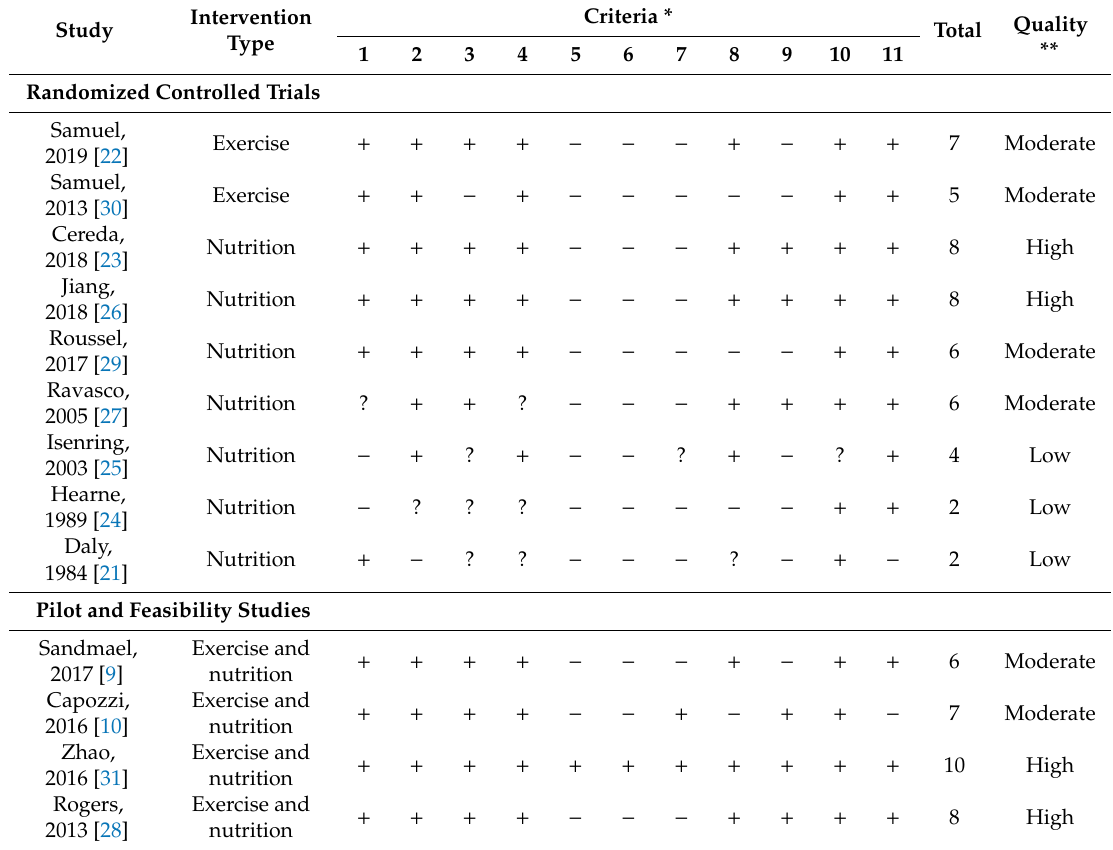
Table 3. Methodological quality assessment: Randomized controlled trials on the e ff ectiveness of exercise and / or nutrition interventions on nutritional status, physical function and quality of life in patients with head and neck